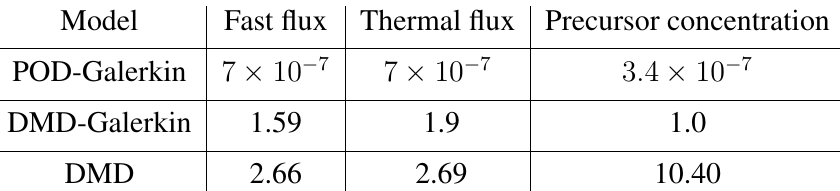
Table 3: Mean Relative Error Percentage in Responses of Interest